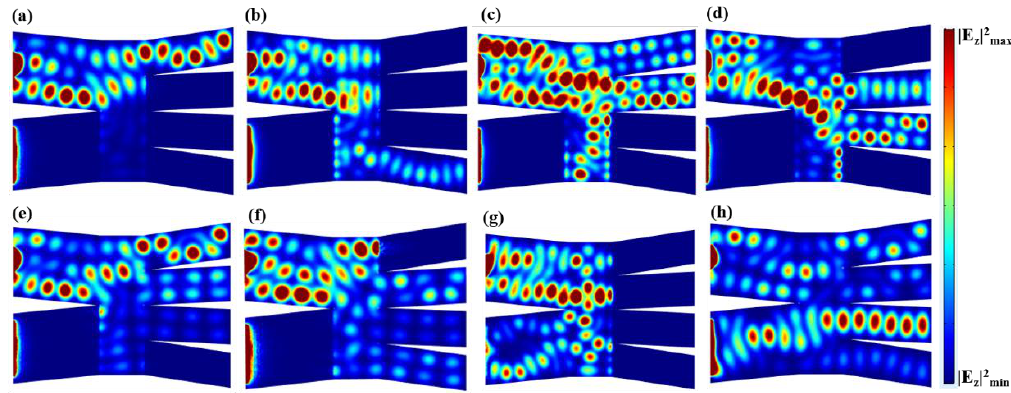
Figure 7. Distributions of |E z | 2 in x - y plane of the two-input four-output switch. When the input branches “I” and “II” are ON and OFF, respectively, corresponding to the input state of “10”, the output branches are in the logical states of ( a ) “1000”; ( b ) “0001”; ( c ) “1100”; ( d ) “0110”; ( e ) “0111” and